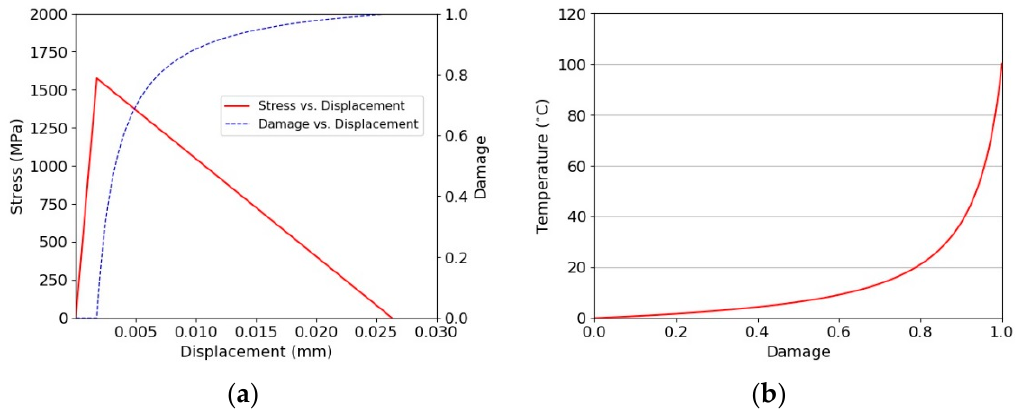
Figure 13. Constitutive model. ( a ) Behaviour for single element test; ( b ) temperature vs damage.